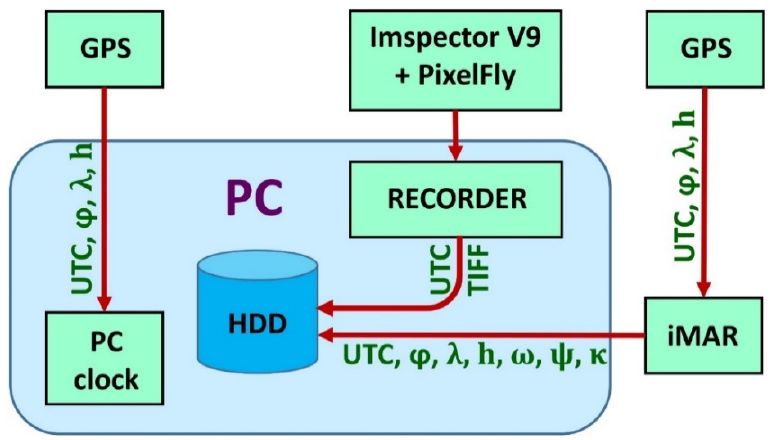
Figure 7. Schematic view of the integrated hyperspectral imaging system comprising ImSpector V9 + PixelFly camera.